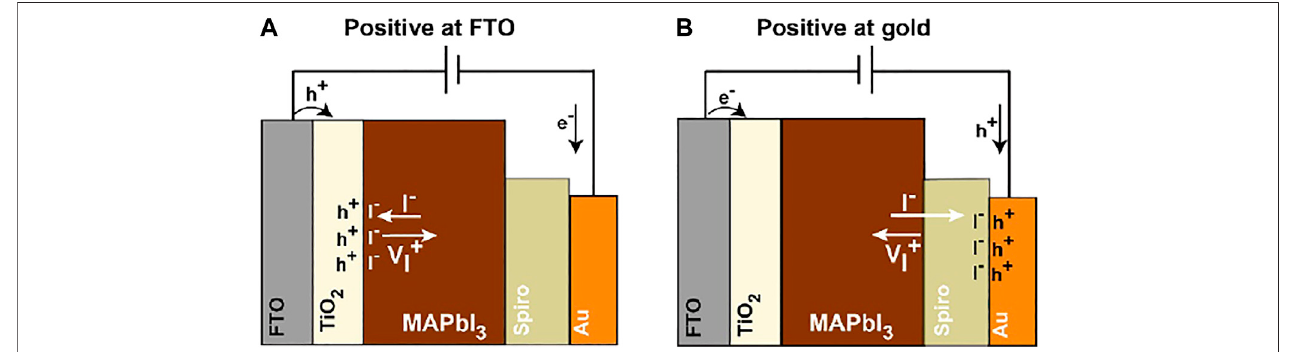
(A) and positive (B) bias in the dark,